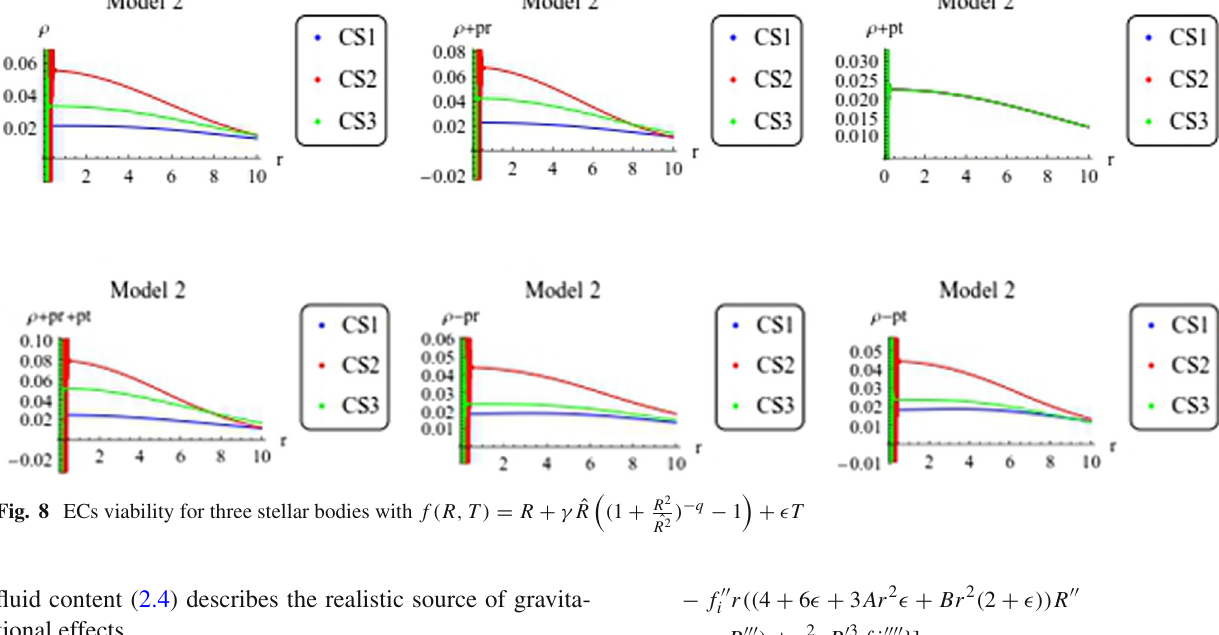
Fig. 8 ECs viability for three stellar bodies with f ( R , T ) = R + γ ˆ R